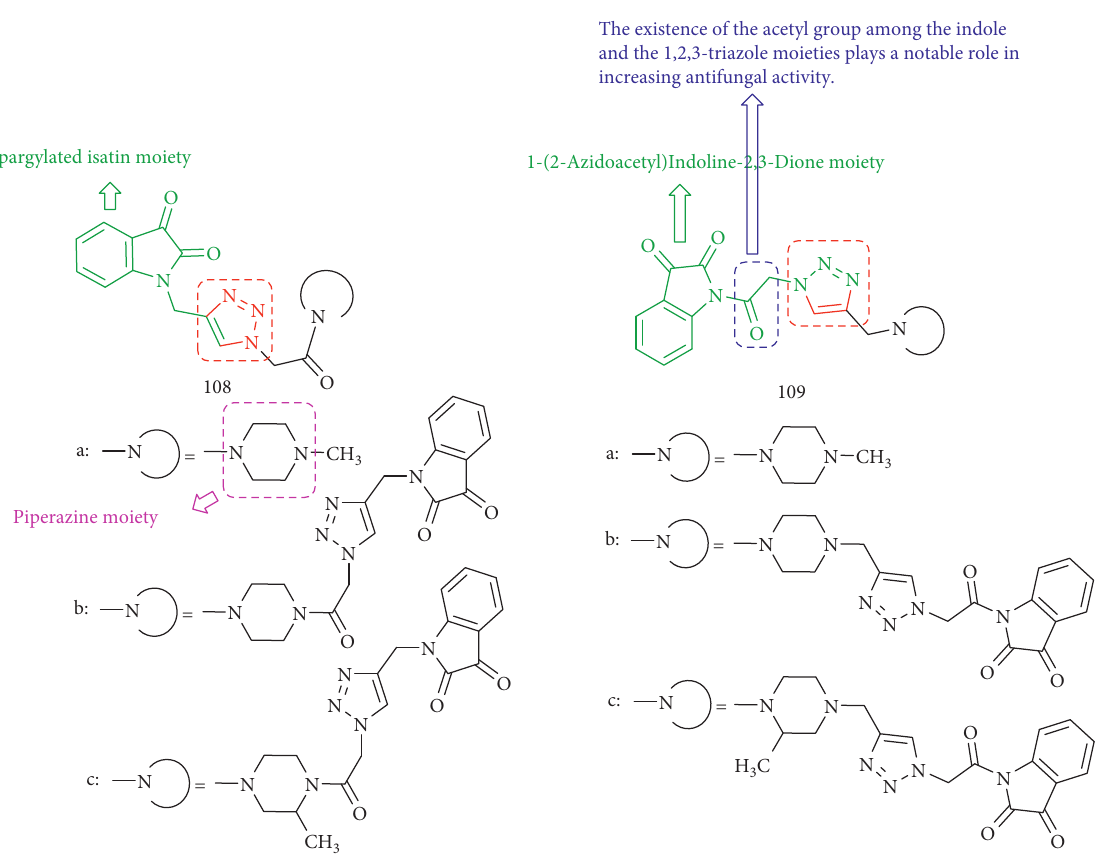
Figure 49: Chemical structure of novel isatin-1,2,3-triazoles with piperidine, morpholine, or piperazine